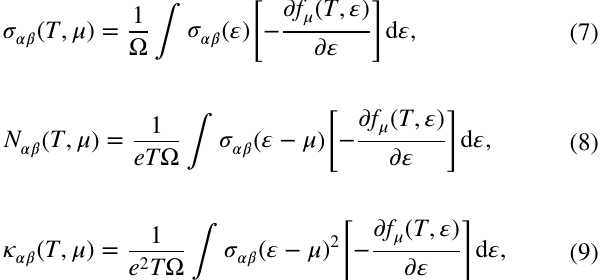
Table 1 The predicted S Coeff values for the TE materials, calculated with the BoltzTrap package that have recently reported in the literature